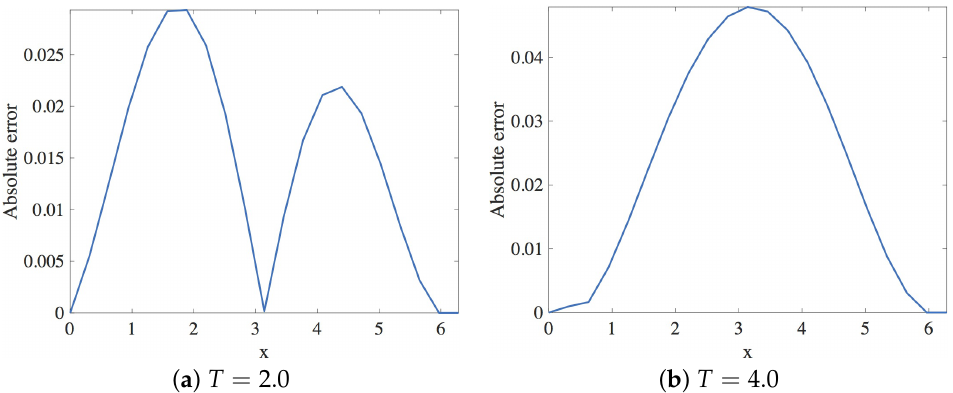
Figure 8. Plot of exact and numerical profiles (using Scheme 2), vs. x at times 2.0 and 4.0 using h = π /10 and k = 0.001.